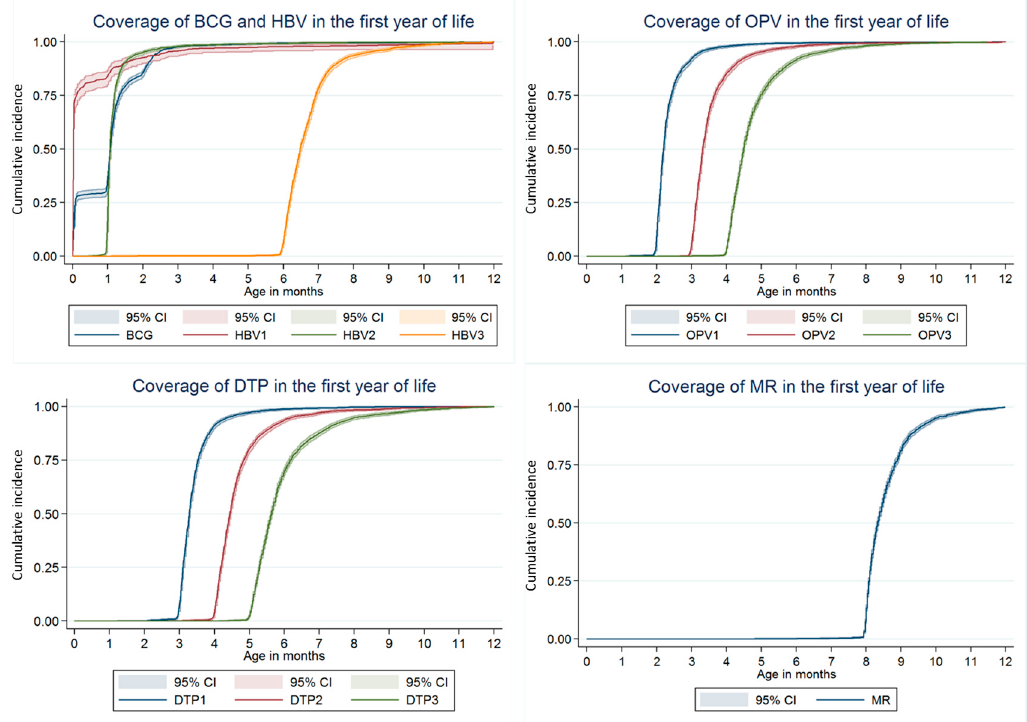
Figure 1. Inverse Kaplan–Meier curves showing the proportion of children immunized with each dose of primary immunizations scheduled in the first year of life among children aged 24–36 months, in Zhejiang province, in 2013 ( N = 2772).